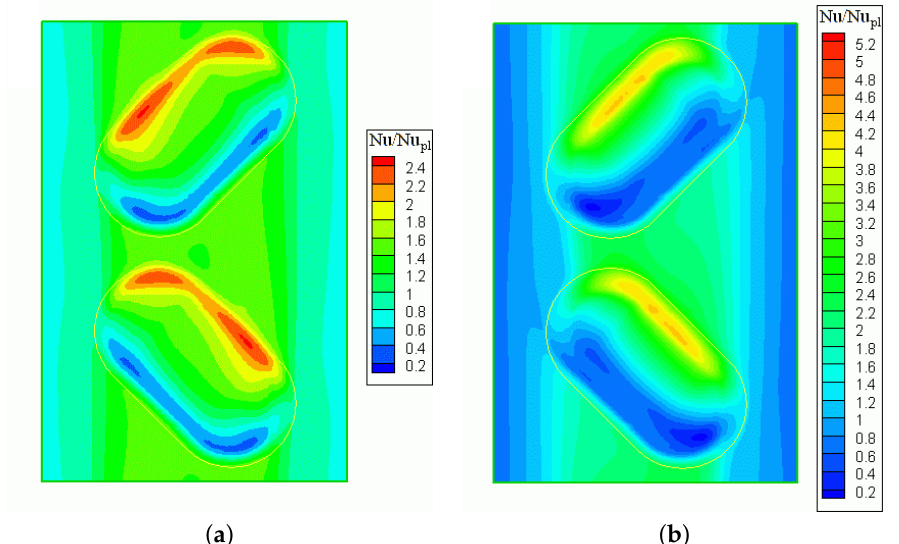
Figure 11. Comparison of fields of relative Nusselt numbers for reliefs with oval dimples 0.1 ( a ) and 0.2 ( b ) deep.